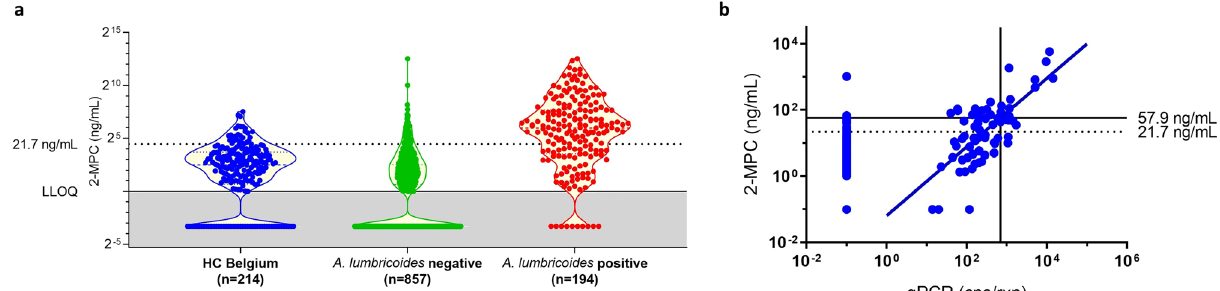
Figure 3. Determination of a low and high cut-off for detection of infection. ( a ) Quantification of urinary 2-MPC in A. lumbricoides -positive (red, n = 195) subjects, endemic controls (green, n = 858) and healthy Belgian controls (blue, n = 214). Grey area indicates samples that were below lower limit of quantification (1 ng/mL). A low cut-off to identify A. lumbricoides -infected subjects was determined using ROC analysis of A. lumbricoides - positive vs. healthy controls and found to be 21.7 ng/mL. ( b ) Correlation between urinary 2-MPC and A. lumbricoides DNA detection in stool collected in Kenya (expressed in A. lumbricoides copies/reaction) was used to determine a high cut-off of 57.9 ng/mL 2-MPC that could be used to identify subjects with moderate-to-high infection. Moderate infection was defined as > 700 cps/rxn (see “Materials and methods”